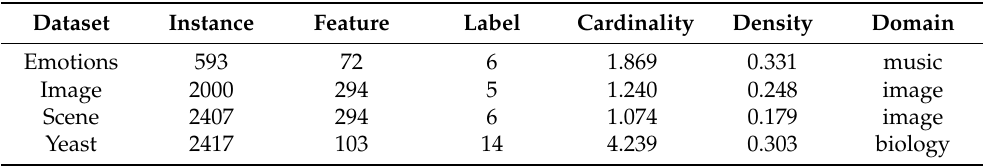
Table 3. Statistics of the benchmark experimental datasets. (“Cardinality” indicates the average number of labels per example. “Density” normalizes the “Cardinality” by the number of possible labels. These datasets can be obtained from the reference [27]).